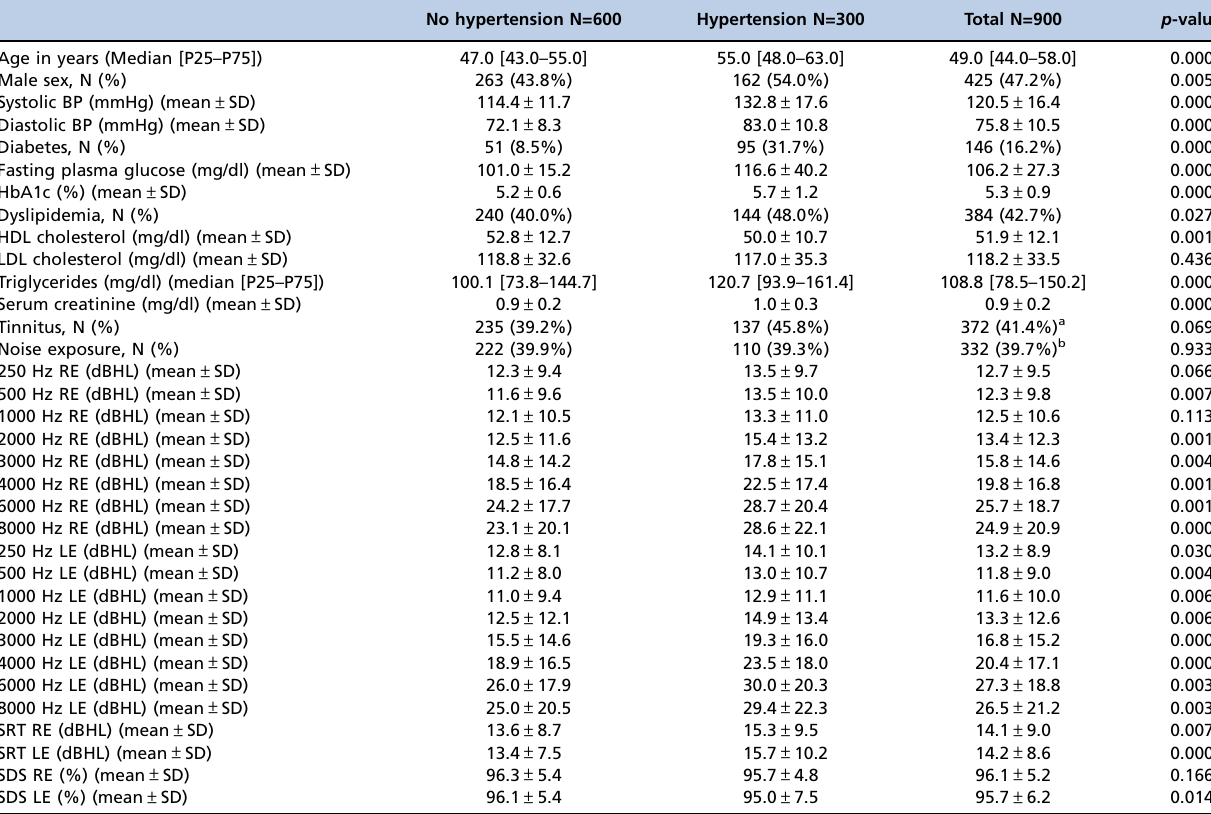
Table 1 - Baseline characteristics of the study